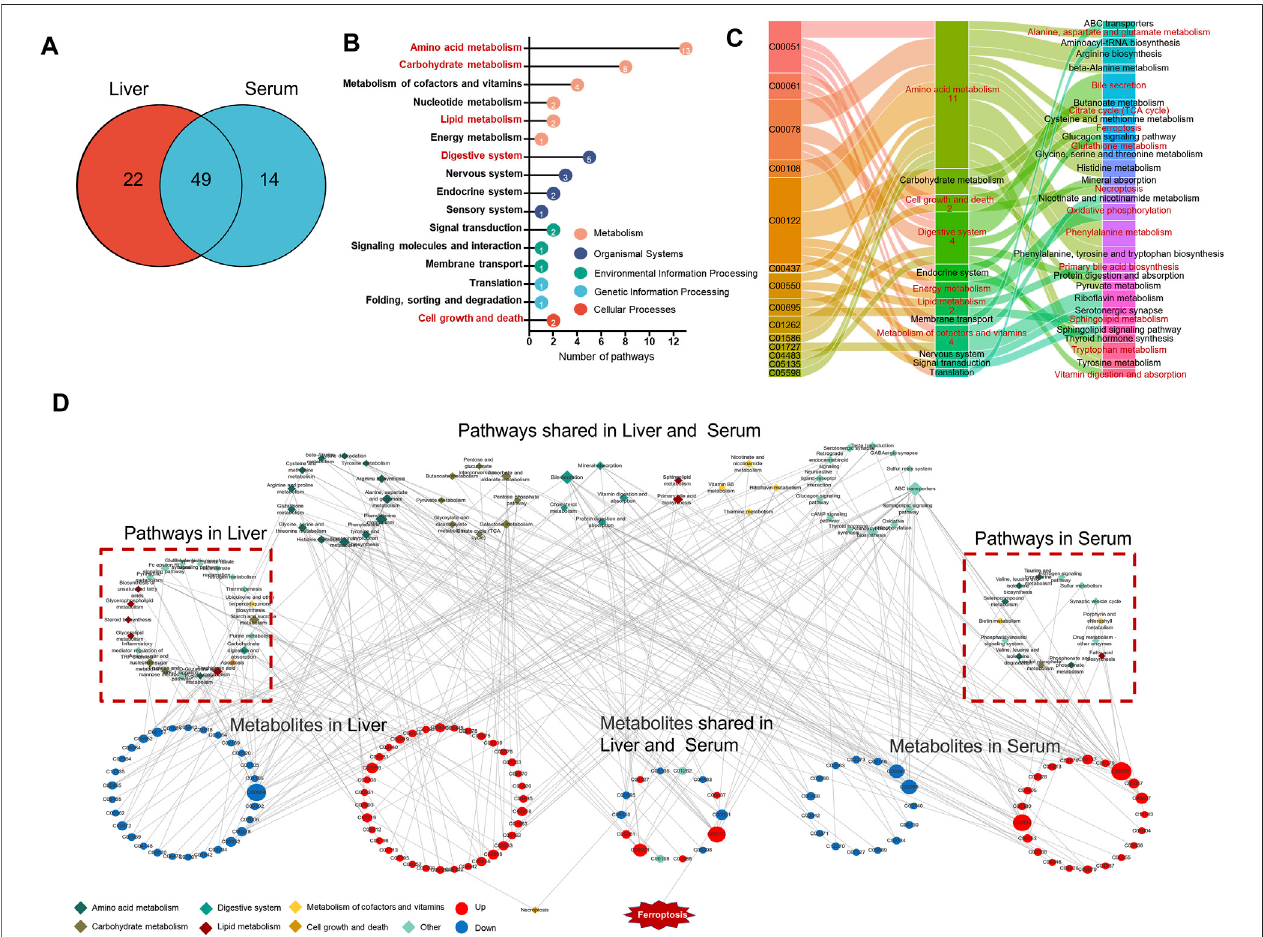
FIGURE5| Themetabolicpathwaysand metabolism-relatednetworksofthedifferential metabolites. (A) Venndiagramshowingthenumber ofshared andunique pathways for liver and serum differential metabolites. (B) Cleveland dot plots show the categories of 49 metabolic pathways shared by liver and serum. (C) Sankey diagrams show the relationship of 14 metabolites shared by the liver and serum with key metabolic pathways. (D) Network of liver and serum differential metabolites in relation to the KEGG pathway.